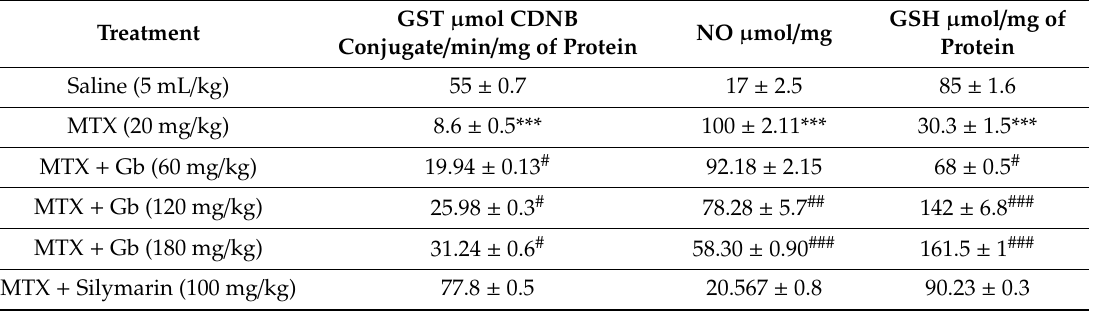
Table 3. E ff ect of Gb on hepatic oxidative